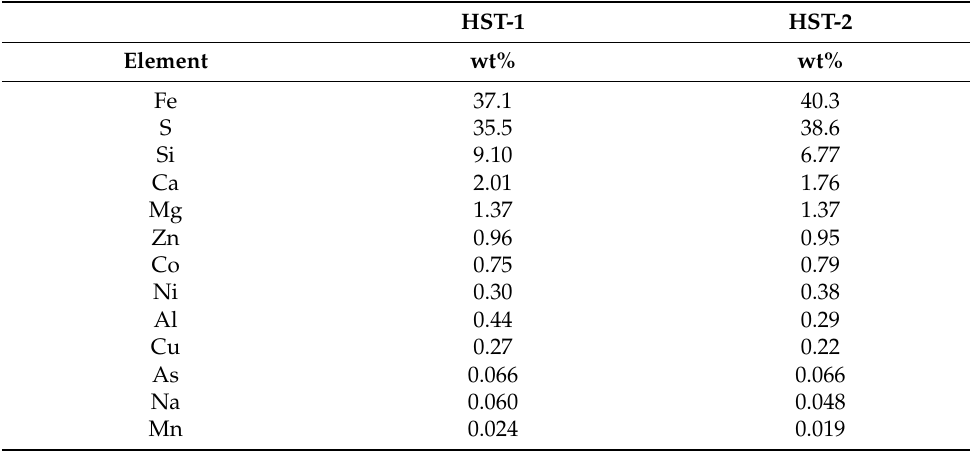
Table 1. Elemental composition of HST-1 and HST-2 sample batches.